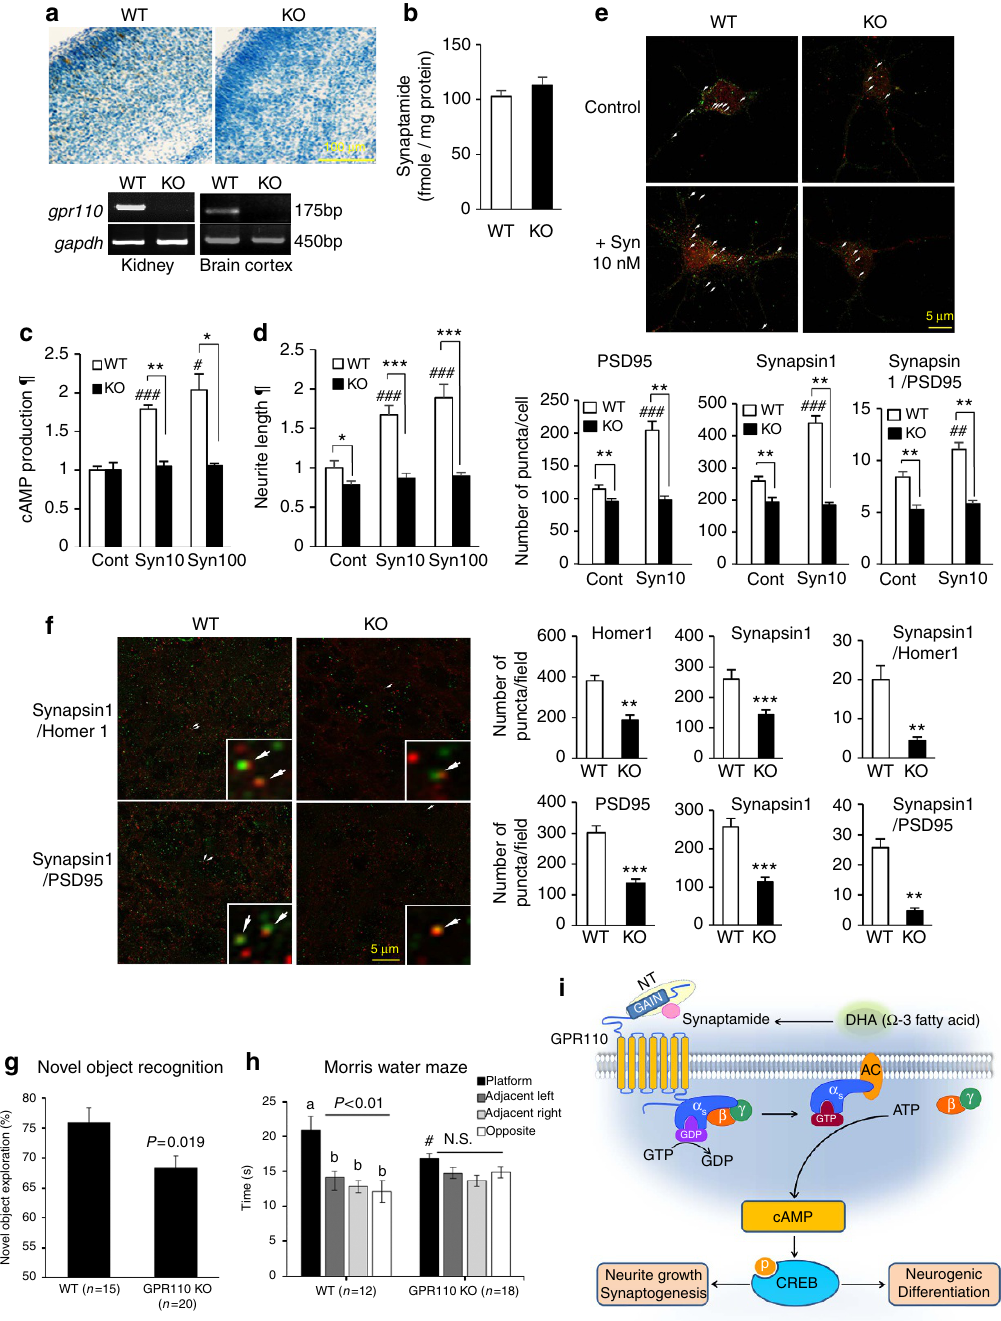
Figure 7 | Synaptamide bioactivity abolished by GPR110 KO. No expression of gpr110 in GPR110 KO kidney and brain cortex indicated by PCR and in situ